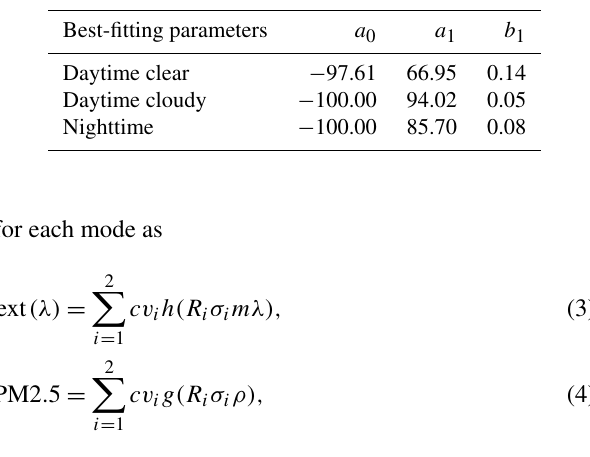
Figure 1. Comparison of R 2 out of the 100 independent cross- validations for the model without meteorological variables (Eq. 11) and the model with meteorological variables (Eq. 12) based on all the available daytime clear-sky cases at the HUBC site. Table 1. Parameters based on the best fitting of 100 independent tests for Eq.